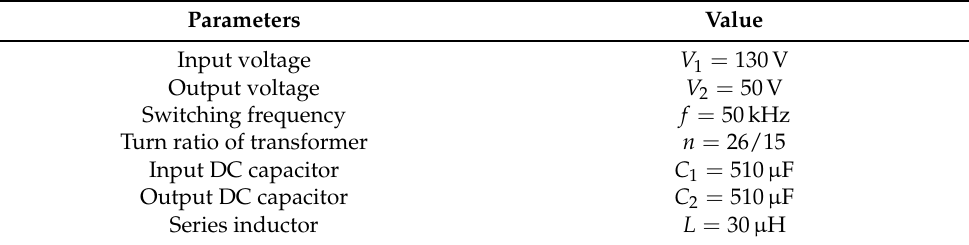
Figure 6. Experiment platform. Table 4. Experimental platform